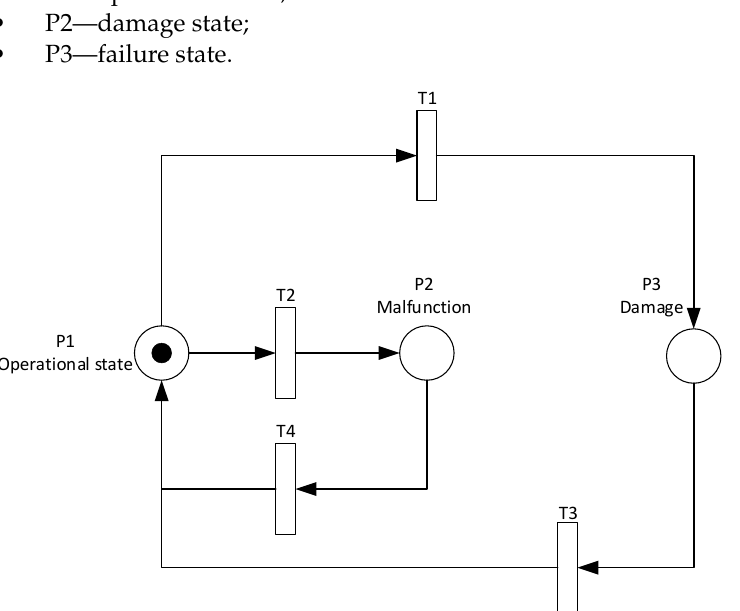
Figure 3. GSPN graph for a basic component of the coal mill. The model consists of three states where stochastic transition values are calculated based on probabilistic density distributions. The initial state is P1, as marked on the graph with a